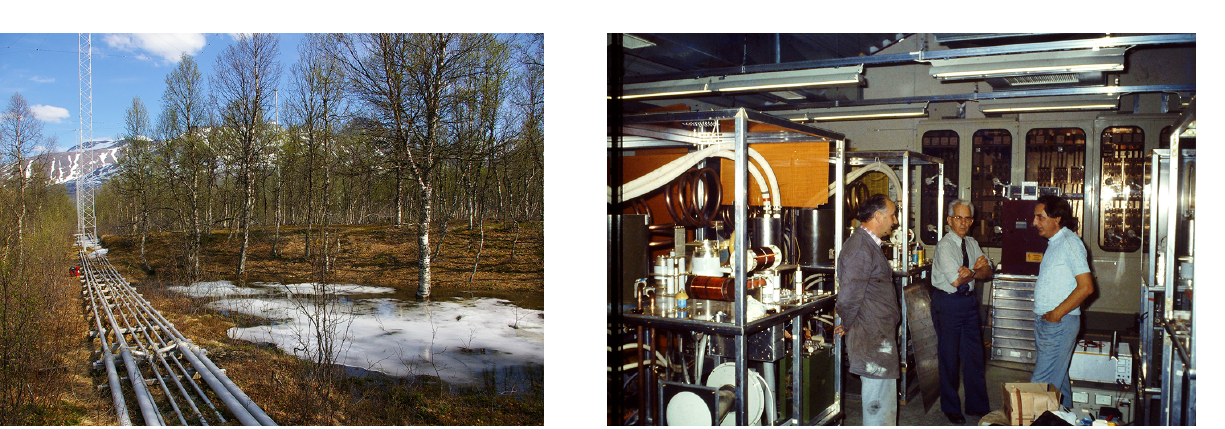
Figure 3. The fabricated coaxial cables and towers in one row of antennas of Array 2 in spring of 2010. The vertical tubes, which are part of the tower supporting the antenna, are also coaxial cables acting as quarter-wave transformers supplying the radio frequency (RF) current to the antenna. Array 3 has an identical design but is smaller in size. Originally, Array 1 had similar antennas, larger in size, but these were modified after the storm in 1985. (Photo credit: Michael T. Rietveld)